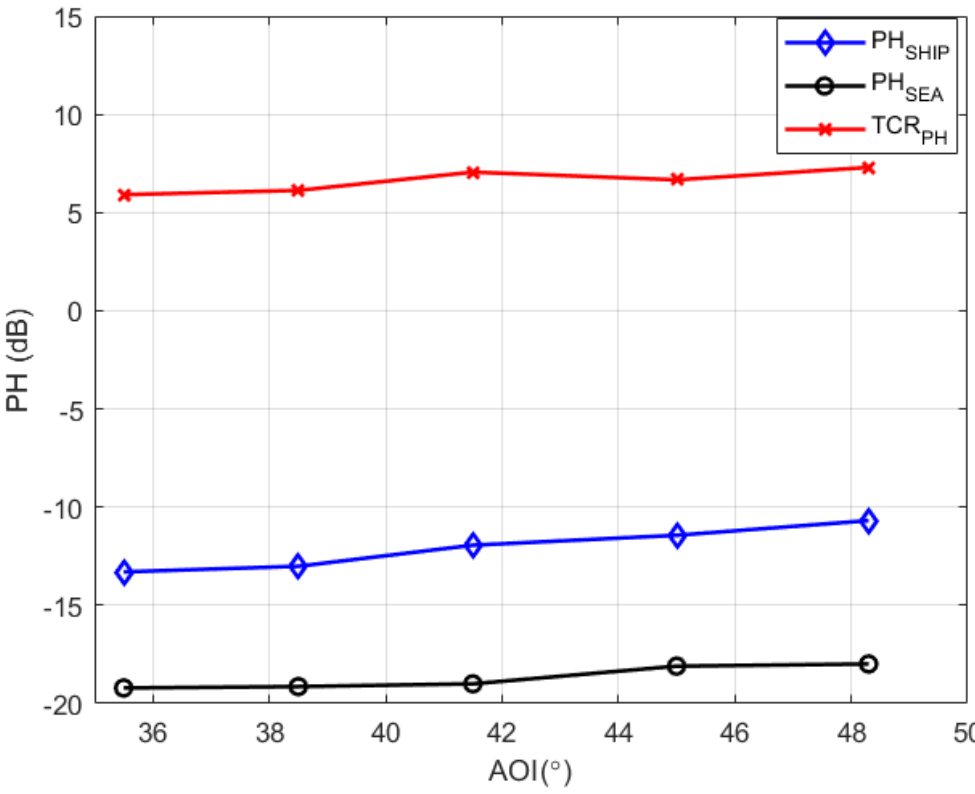
Figure 13. Behaviour of the PH and its corresponding TCR. Black and blue lines refer to sea and ship ROIs, while the red plot refers to the TCR. The dB scale is